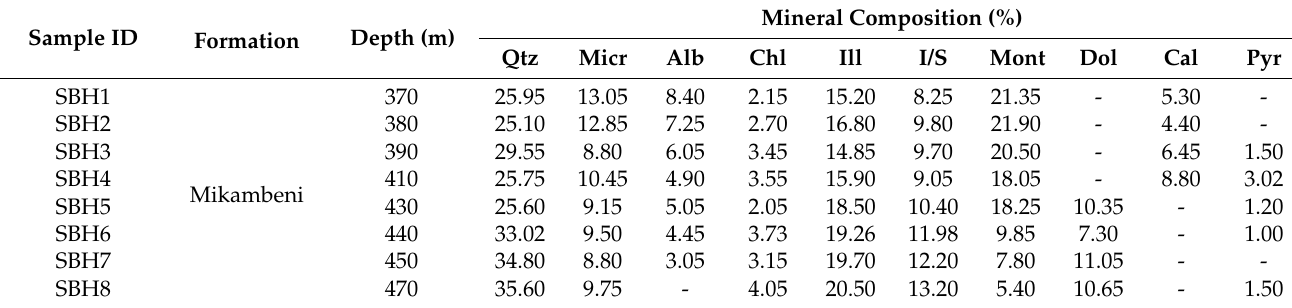
Note: Qtz—Quartz, Micr—Microcline, Alb—Albite, Chl—Chlorite, Ill—Illite, I/S—Mixed Iliite/Smectite, Mont—Montmorillonite, Dol—Dolomite, Calcite—Cal,